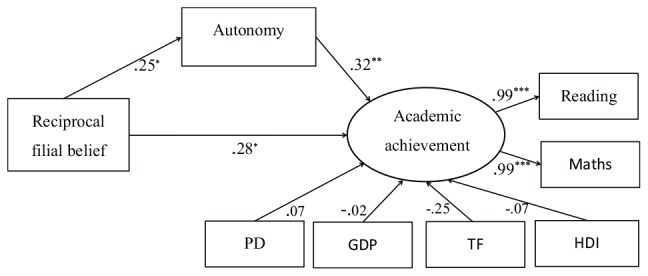
The relationships between reciprocal filial belief, autonomy, and academic achievement (Study 2). ∗p < 0.05, ∗∗p < 0.01, ∗∗∗p < 0.001. PD, population density; TF, total fertility (live births per woman); HDI, human development index.